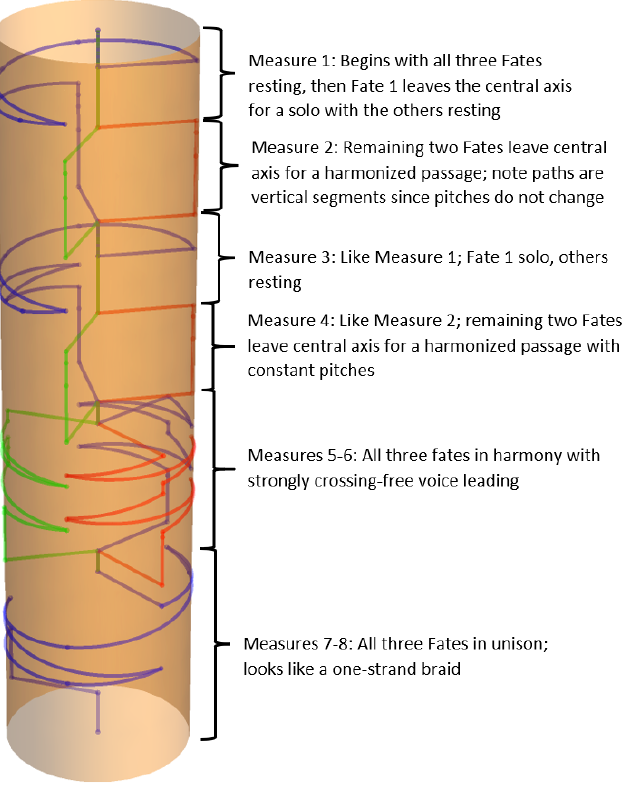
Figure 11. The Hadestown example as a singular braid. The blue strand is Fate 1, the red strand is Fate 2, and the green strand is Fate 3. Resting voices are on the central axis; sounding voices are on the curved outer